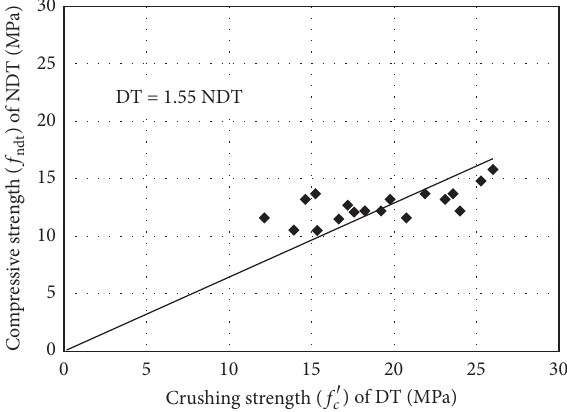
Figure 8: Tensile strength of concrete.